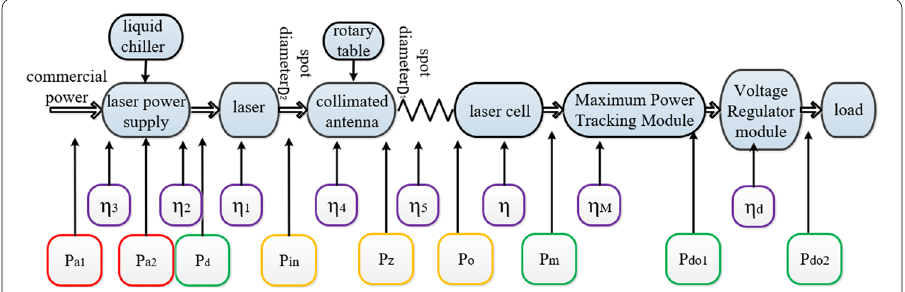
Fig. 11 Overall measurement point